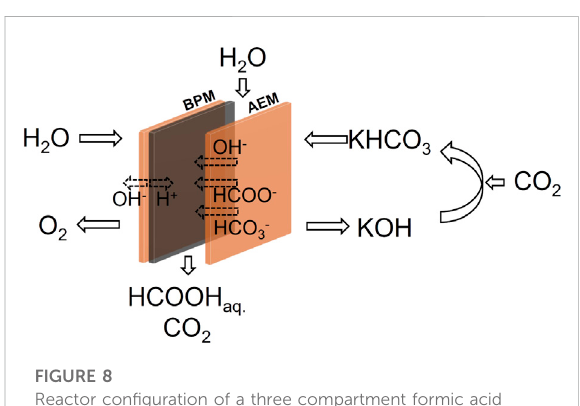
FIGURE 8 Reactor con fi guration of a three compartment formic acid electrolyser with recirculated bicarbonate